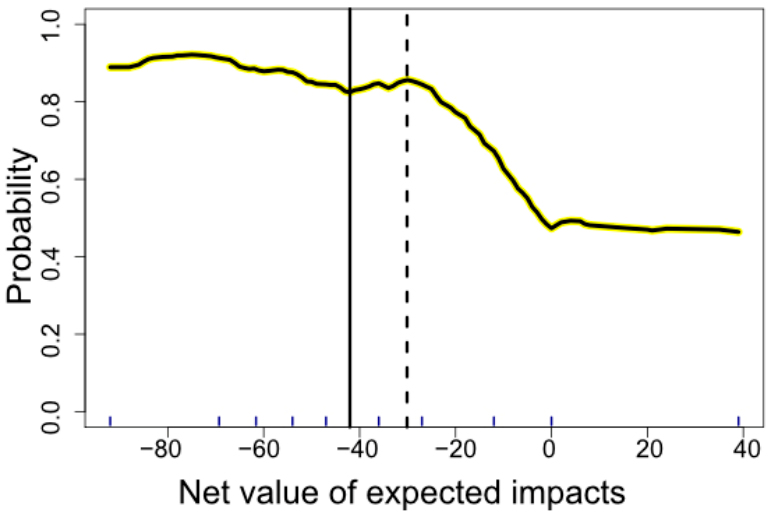
Figure 4. The equivalent of expected utility from decisions in favour of mitigation. A BART model of the probability of decision-making promoting climate change mitigation based on the net value of expected climate change impacts was constructed. Probabilities were taken as the equivalents of the utility expected from decisions in favour of mitigation (see Figure S2 and Table S2). Breakpoints for negative tipping point behaviour of two kinds are shown as lines below which tipping point behaviour can occur. ‘Decision maker ´ s tipping point behaviour’ is shown as a dashed line, and ‘Systemic tipping point behaviour’ is shown as a full